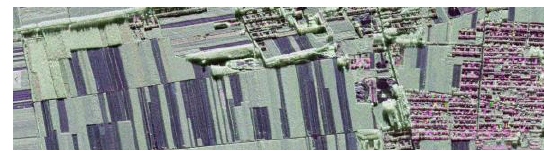
Figure 1. Airborne C-band Pauli-RGB image over Zunhua in August 2015. The top row is the nearest range.